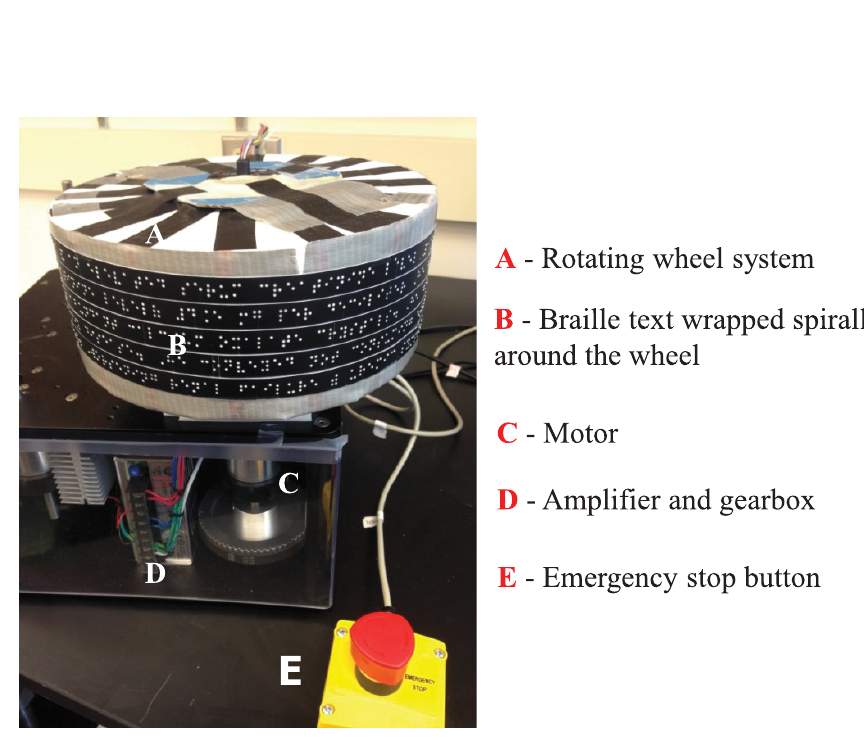
Fig 10. Experimental setup used in the human subject testing with blind individuals. Setup components marked on the picture are explained on the right hand side with matching